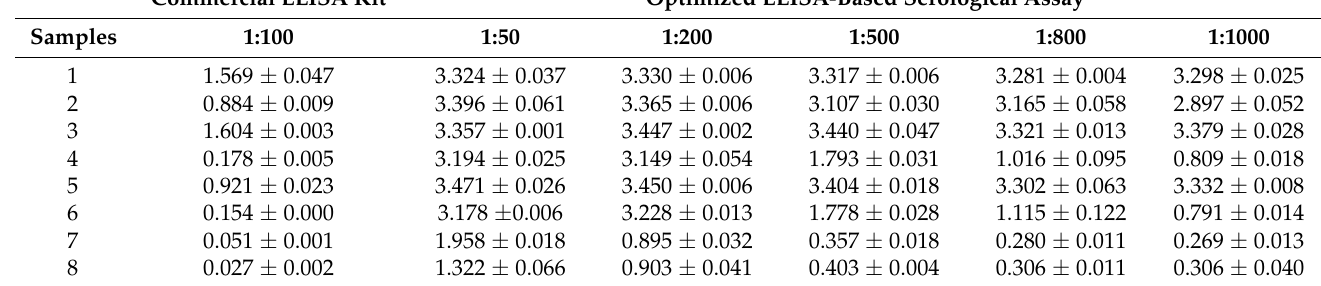
Table 2. Determination of proper human serum dilution, performed in the optimized ELI- SA-based serology assay. Optical density values are shown for eight randomly chosen samples assayed in duplicate. Different sample dilutions were measured with the optimized serology assay in comparison with the commercial ELISA kit at the manufacturer’s recommended dilution. Re- sults are the mean ± S.D.